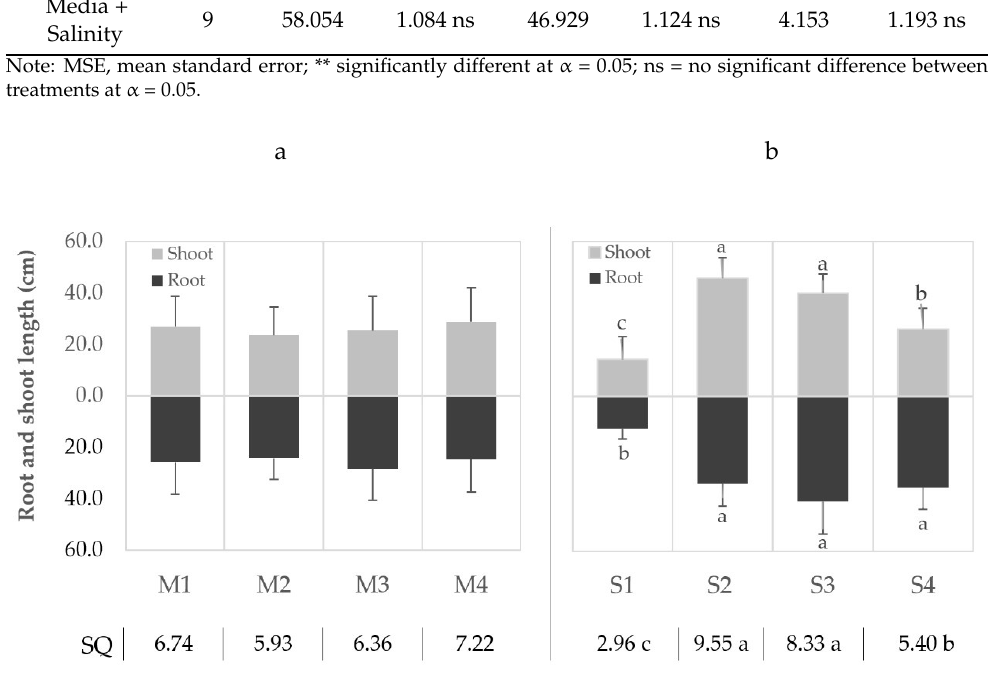
Table 3. Effect of water salinity and media composition on root, shoot, and leaf biomass (g) of 14 week old Avicenna marina (Forssk.) Vierh. seedlings.